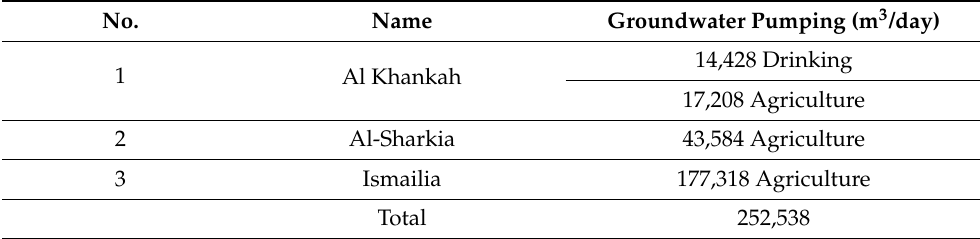
Table 2. Available groundwater pumped in the study area [45,46].